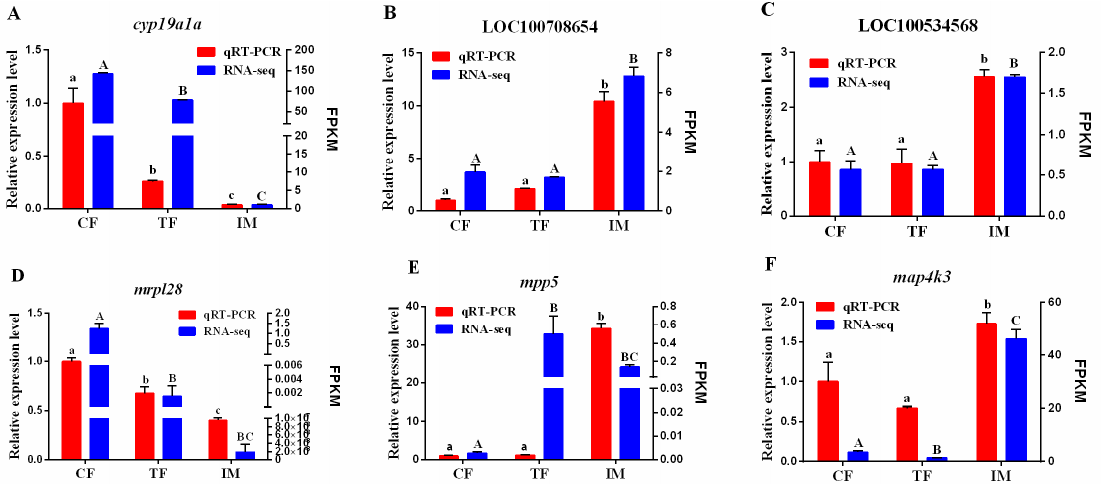
Figure 6. qRT-PCR validation of RNA-Seq data. ( A ): cyp19a1a ; ( B ): LOC100708654; ( C ): LOC100534568; ( D ): mrpl28 ; ( E ): mpp5 ; ( F ): map4k3 . The left Y -axis represent the relative expression level determined by qRT-PCR, and the right Y -axis represent FPKM determined by RNA-Seq. The scales of the left and right Y -axis are different. All data represent the mean value of three biological replicates. Error bars represent the standard errors of three replicates. Different lowercase letters (in qRT-PCR) and capital letters (RNA-seq) show statistical significance between variables, according to one-way ANOVA and post-hoc Duncan’s multiple range tests ( p < 0.05).